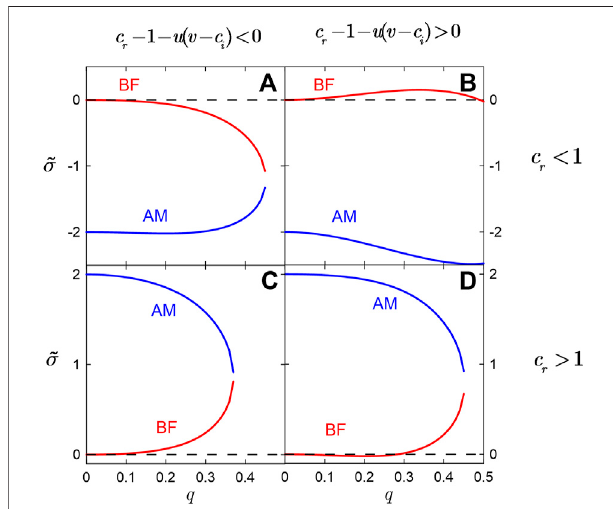
FIGURE 1 | Growth rate of modulational instabilities as the function of wavenumber q for different values of c and v , u (cid:1) 2. (A) c (cid:1) iv , (B) c (cid:1) i ( v + 2 ) , (C) c (cid:1) 2 + i ( v − 1 ) , (D) c (cid:1) 2 + iv . Branches corresponding to the amplitude modulation instability and the phase modulation (Benjamin – Feir) instability are marked as “ AM ” and “ BF, ”